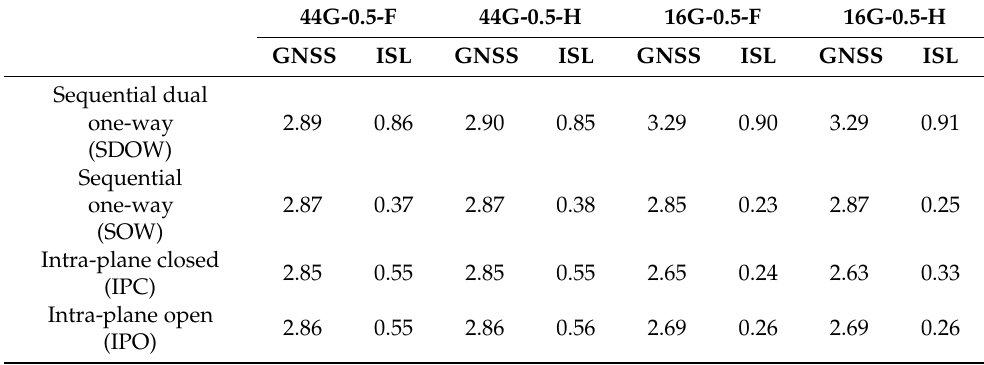
obtained for normal equations for GNSS and S 2